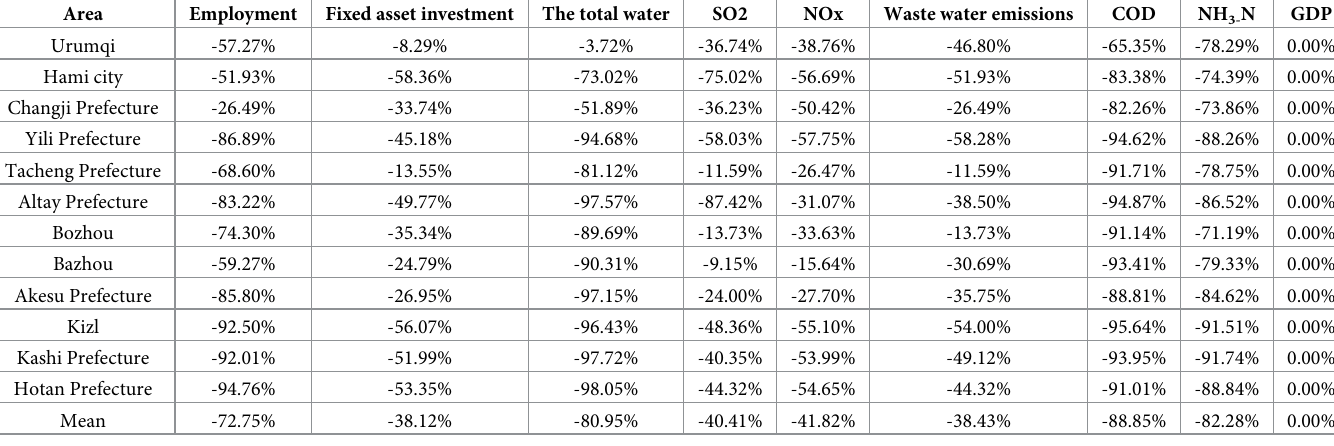
Table 7. Redundancy rate of the input-output index of eco-efficiency in different prefectures of Xinjiang.